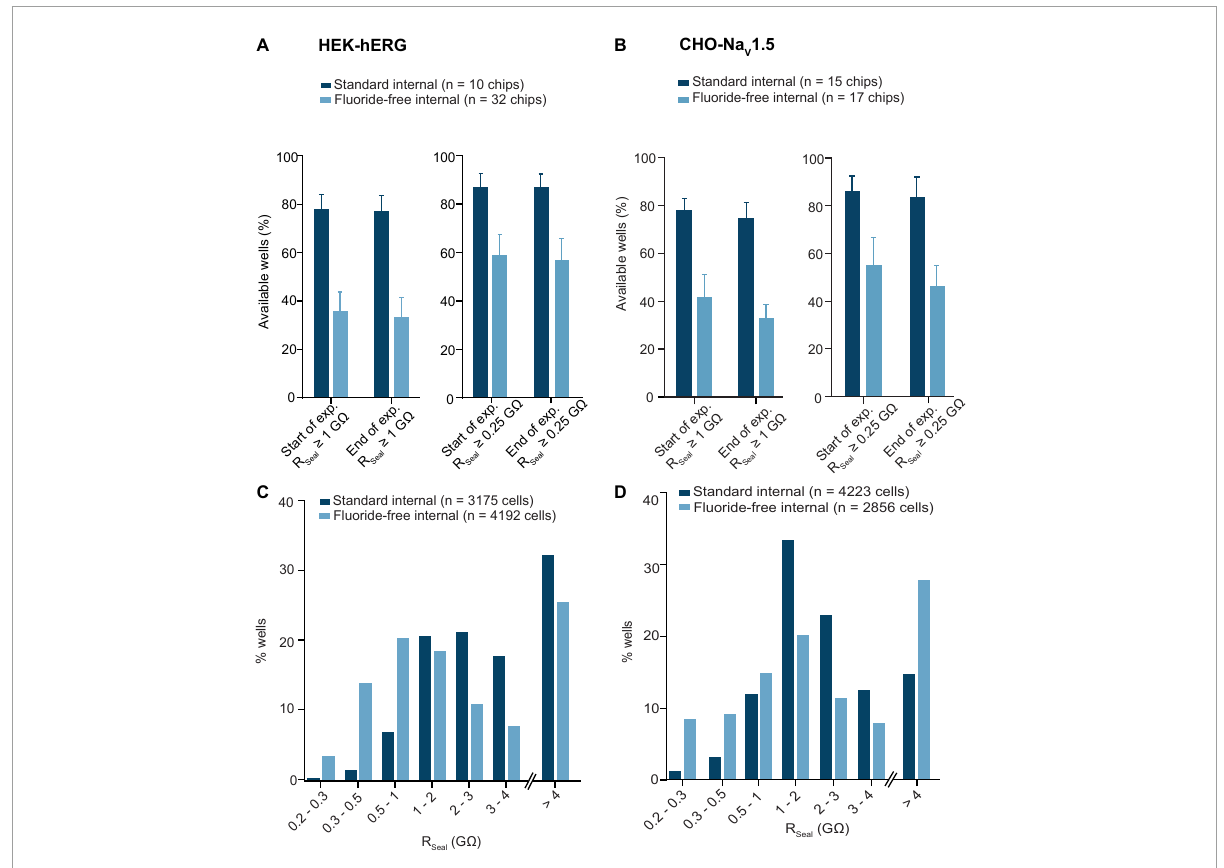
FIGURE1 HEK and CHO cells recorded in standard and fluoride-free internal solution. (A) HEK cells expressing hERG were captured with almost 80% success rate for R Seal ≥ 1 G (cid:127) + I Tail > 150 pA and almost 40% success rate for R Seal ≥ 1 G (cid:127) in fluoride-free internal solution (left). If a QC cutoff of R Seal ≥ 0.25 G (cid:127) + I Tail > 150 pA was used, the success rate was increased in both conditions (right). (B) CHO cells expressing Na V 1.5 were captured with almost 80% success rate for R Seal ≥ 1 G (cid:127) + I Peak < –100 pA and over 40% success rate for R Seal ≥ 1 G (cid:127) in fluoride-free internal solution (left). If a QC cutoff of R Seal ≥ 0.25 G (cid:127) + I Peak < –100 pA was used, the success rate was increased in both conditions (right). (C) Histogram plot of the R Seal values for HEK-hERG cells in standard and fluoride-free internal solution. For R Seal > 4 G (cid:127) , although they are high giga-seals, the seal resistance is not accurately calculated and is therefore shown as an extra bar and these R Seal values were not included in the calculation for R Seal ( Table 2 ). (D) Histogram plot of the R Seal values for CHO-Na V 1.5 cells in standard and fluoride-free internal. For R Seal > 4 G (cid:127) , although they are high giga-seals, the seal resistance is not accurately calculated and is therefore shown as an extra bar and these R Seal values were not included in the calculation for R Seal ( Table 3 ).